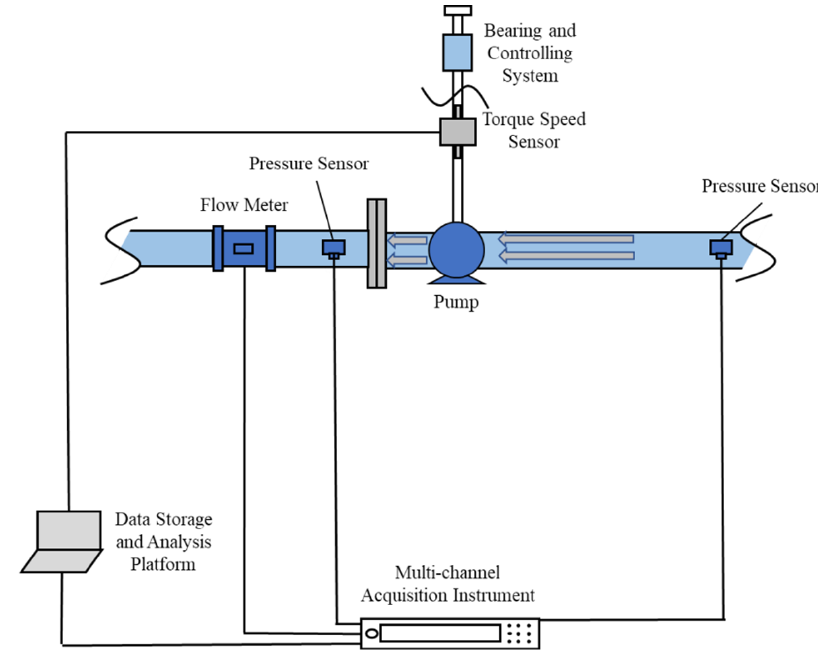
Figure 7. Experimental system of double-suction centrifugal pump.